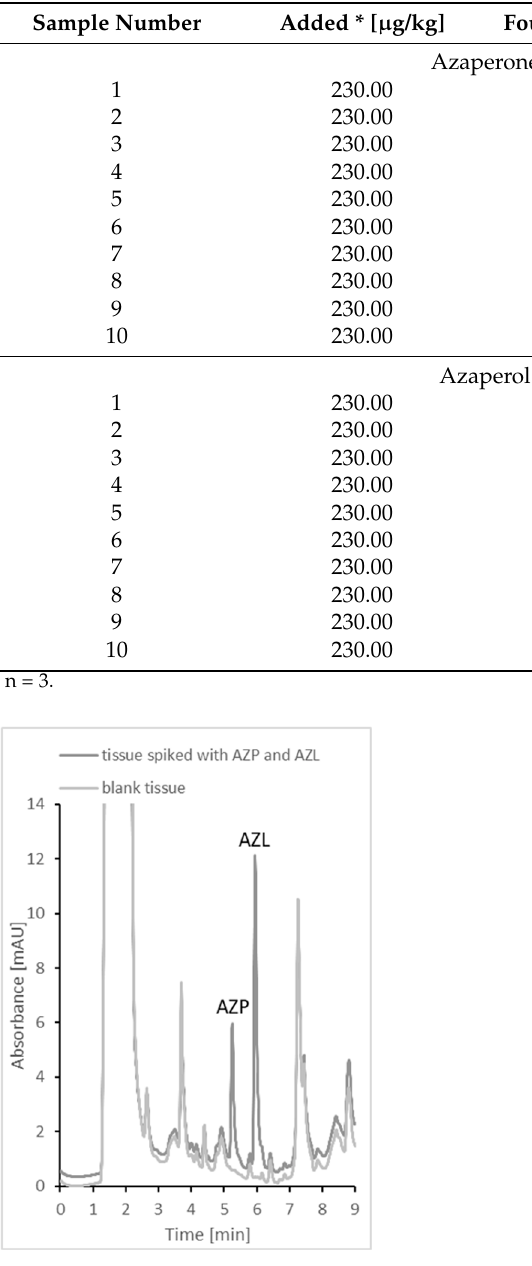
Figure 6. Representative chromatograms of blank tissue and tissue spiked with AZP and AZL (250 µg/kg tissue). Chromatographic conditions are as described in Section 3.3.